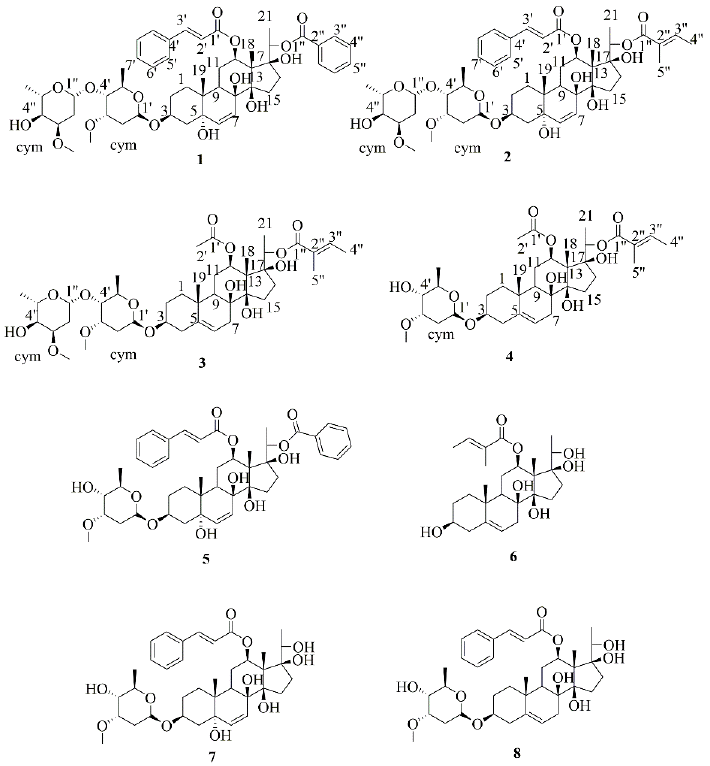
Figure 1. The structures of compounds 1 – 8 .